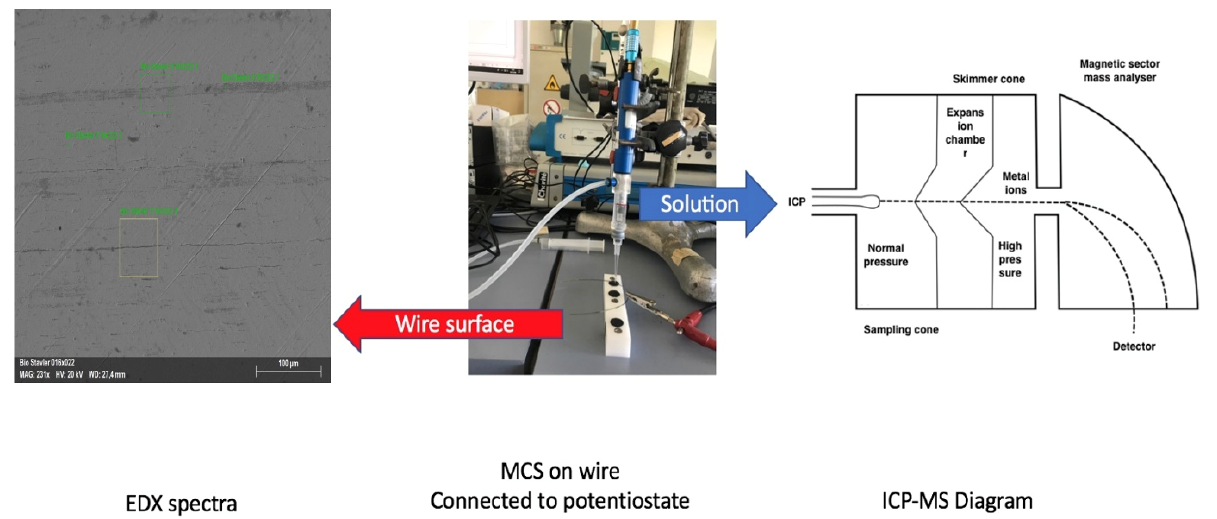
Figure 2. Techniques for assessing the in vitro behavior of orthodontic wires. MCS, Mini Cell System; EDX, x ‐ ray energy ‐ dispersive spectroscopy; ICP ‐ MS, inductively coupled plasma ‐ mass spectrometer.